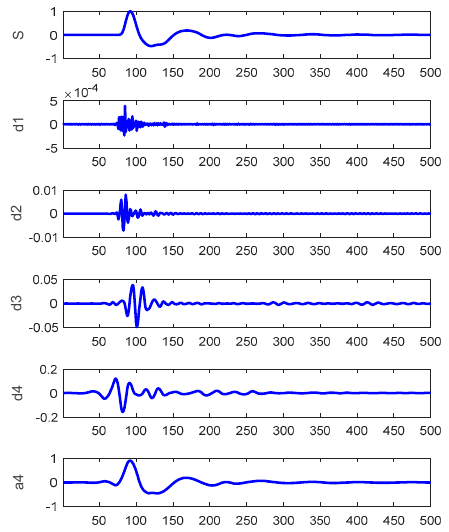
Figure 5. An illustration of 4-level wavelet decomposition of a reflectogram: s = original signal; d1~d4 are the first through fourth details and a4 is the fourth